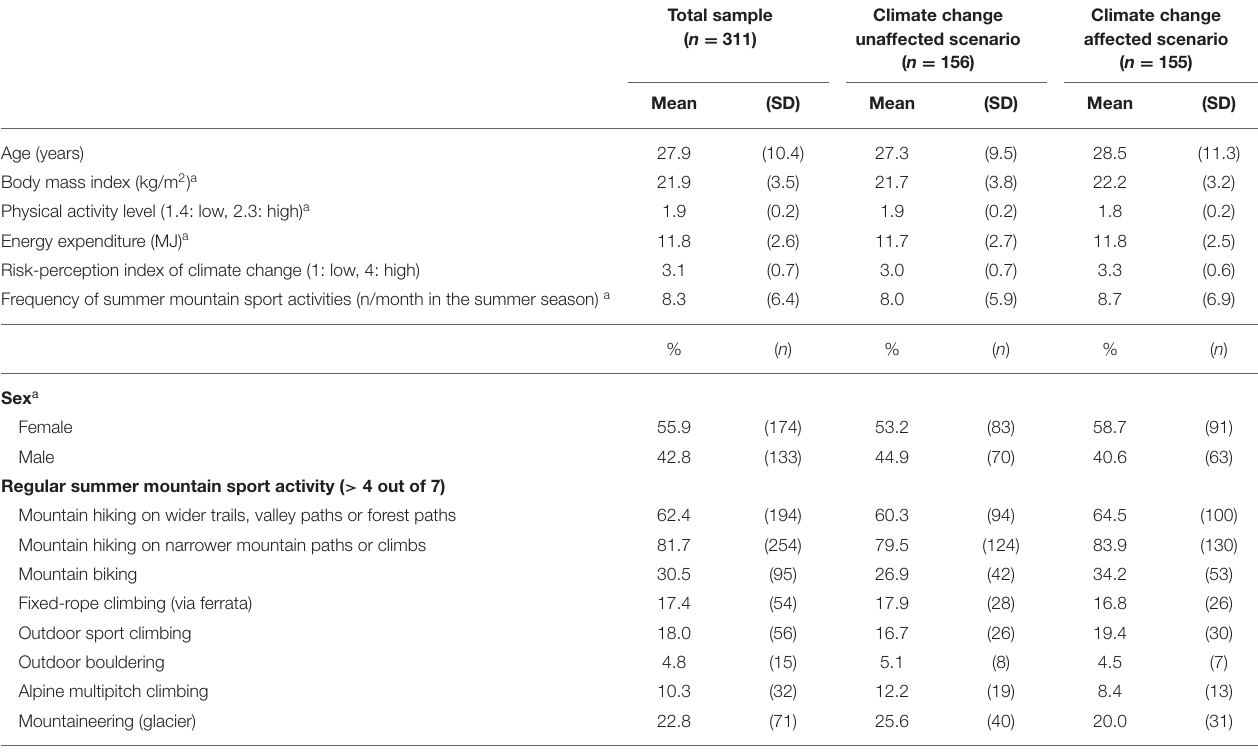
TABLE 1 | Descriptive information on demographic variables, physical activity, risk-perception of climate change, and summer mountain sport activities of the total sample and by group.